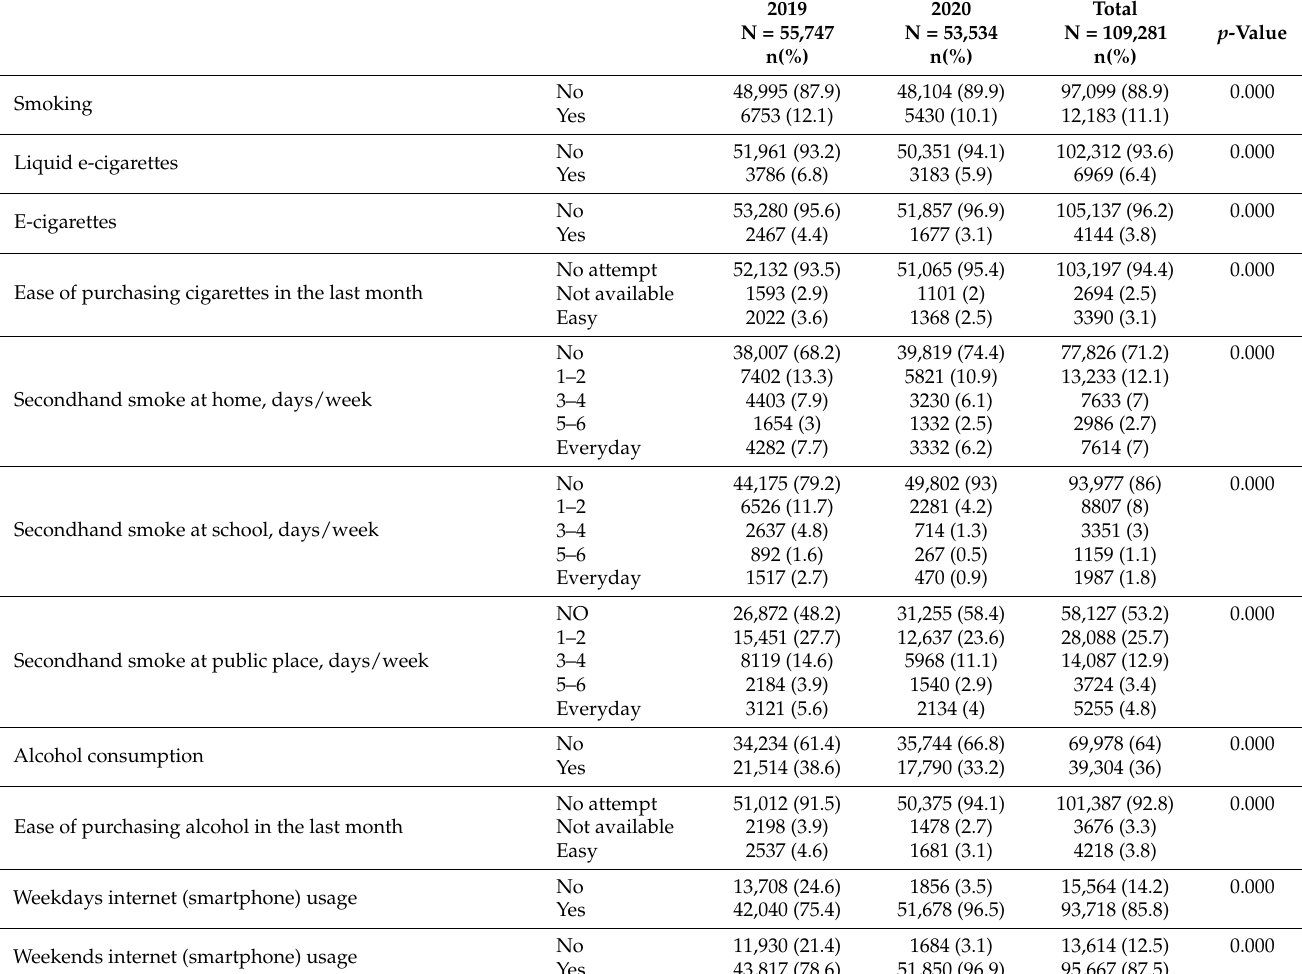
Table 3. Participants’ experience of smoking, alcohol consumption, and internet (smartphone)